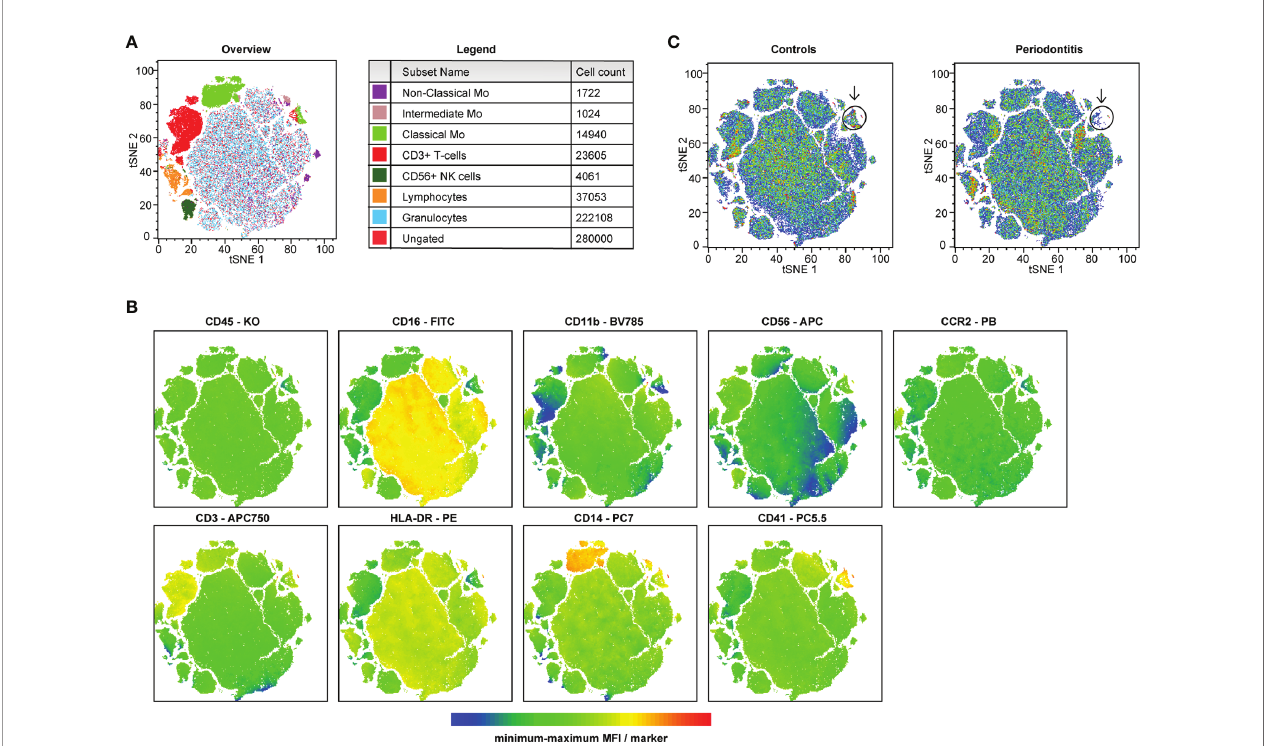
FIGURE 3 | Unsupervisedt-StochasticNeighbor Embedding (tSNE) analysis. Unsupervised tSNE plots show the contribution of each expression marker ineach celltype. (A) The overview presents the identi fi ed circulatingcelltypes, seethe legend within the table. (B) The distribution of each expression marker per celltype. The color depicts the MFI expression of each marker (blue: low MFI, red:high MFI). (C) The difference between control participants (n=14) andparticipants with periodontitis(n=14) isshown for each celltype. The arrow indicates a visualsmaller group of platelet-lymphocyte complexes in the periodontitis ’ group compared to the control